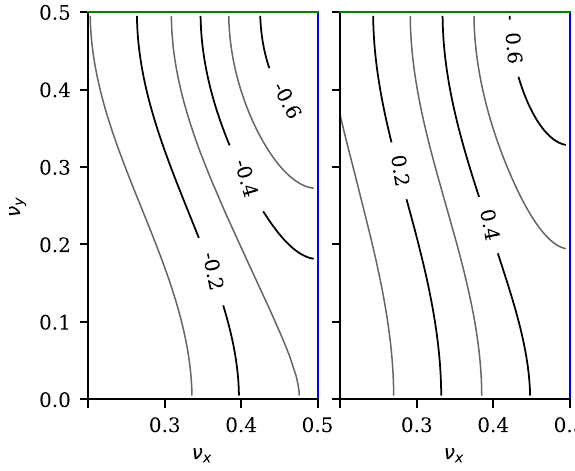
FIG. 7. Values of m 0 (left) and m 1 (right) for optimized emittance ratio F at a given cell tune.